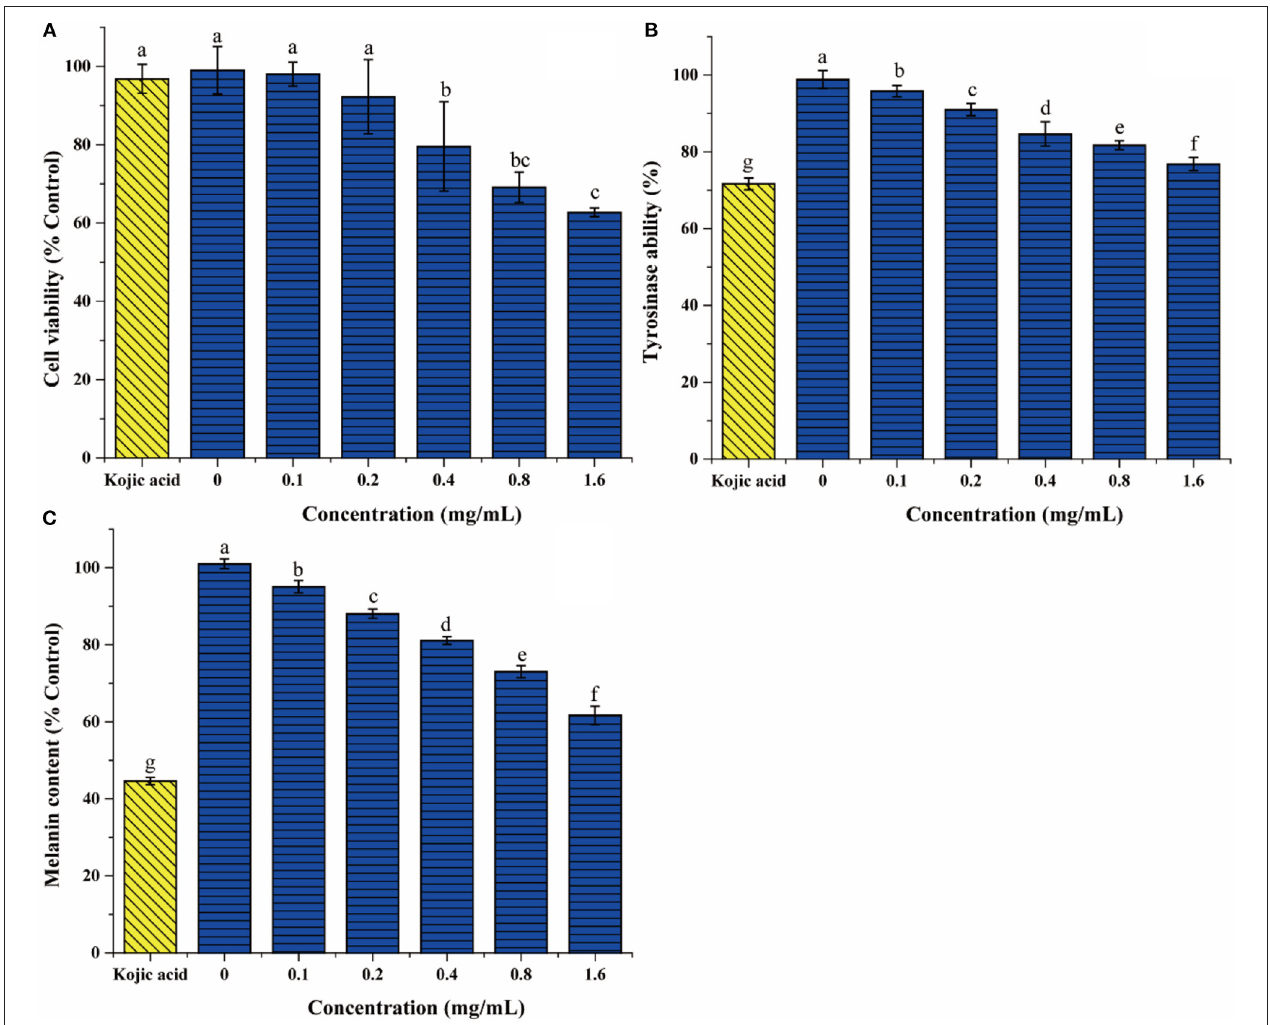
FIGURE 7 | The effect of DLGFLARGF on B16F10 melanoma cells cytotoxicity (A) , tyrosinase activity (B) , and melanin content (C) . Kojic acid (0.75 mg/ml) was used as a positive control. The results are expressed as a percentage of the control, and the value is the mean ± SD of three independent experiments. According to Duncan’s test, different letters indicate that the statistical difference between the two groups is p <